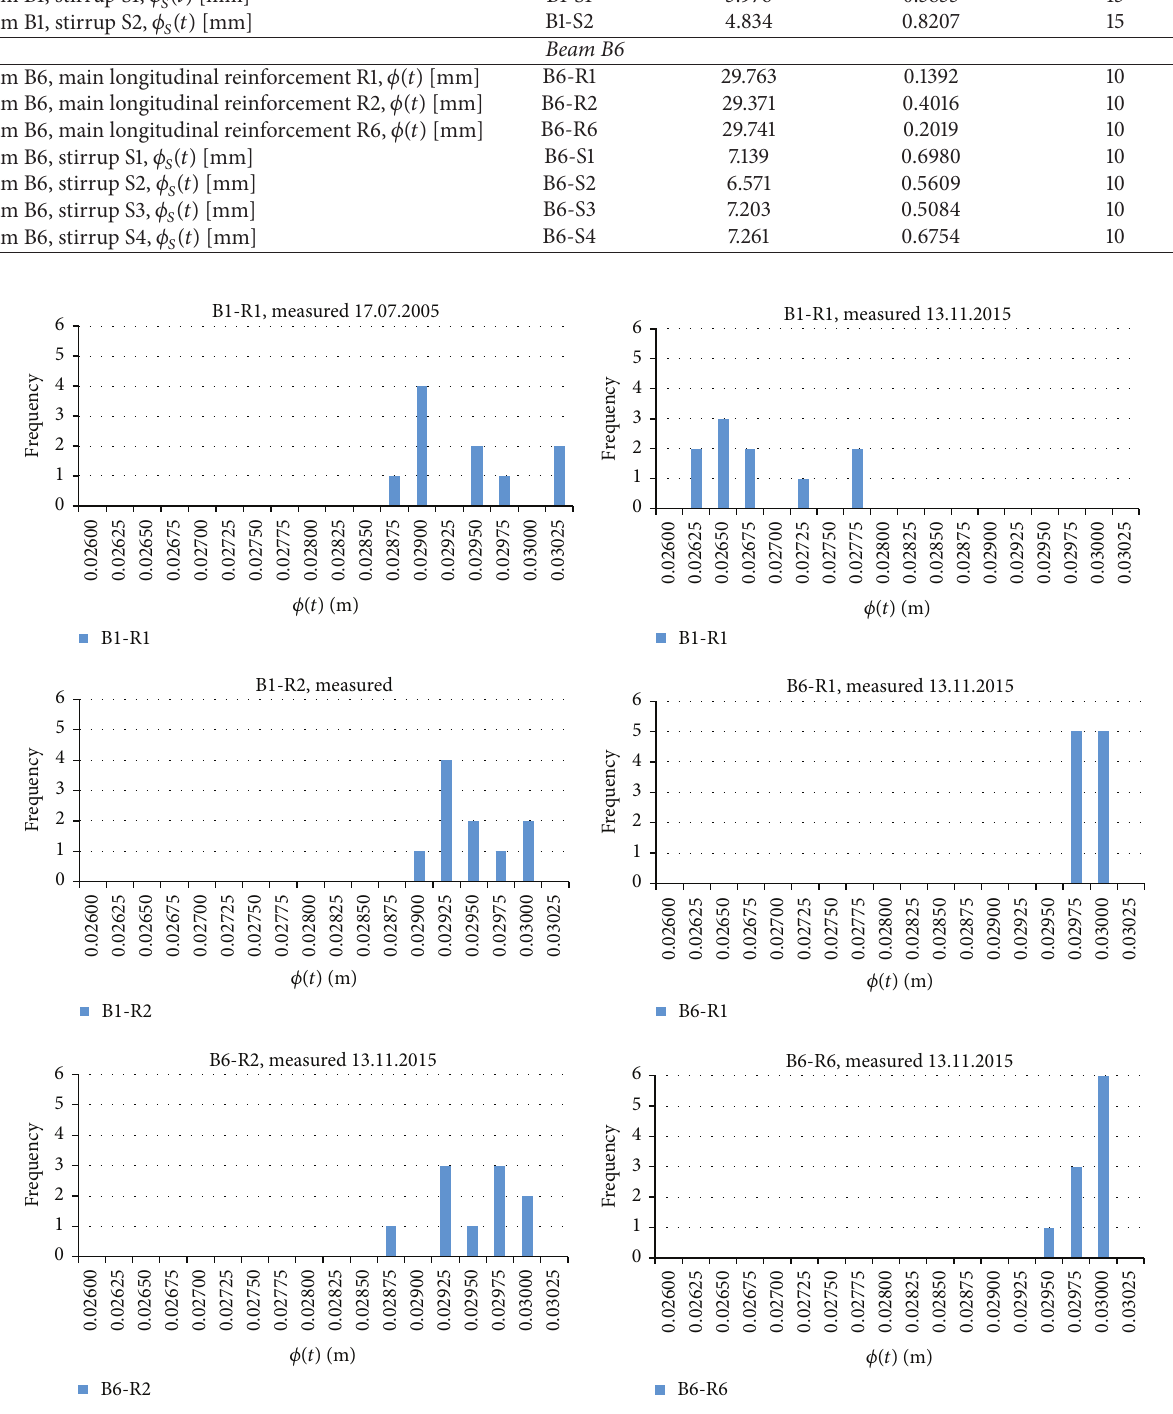
Figure 5: Histograms from measured values of bars’ diameters: longitudinal